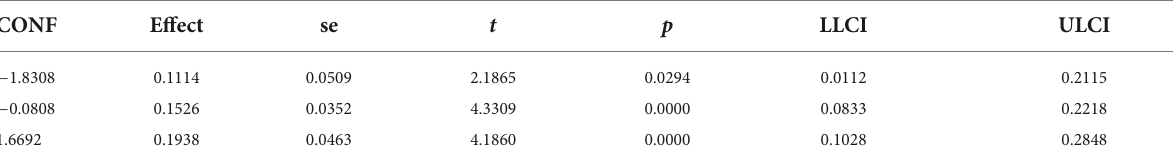
TABLE 5 Direct and indirect effects of the OR1 and index of moderated